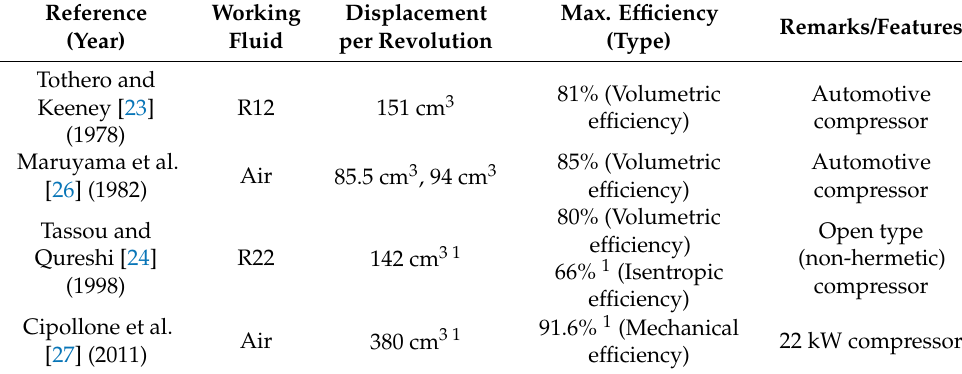
Table 2. Sliding vane compressor